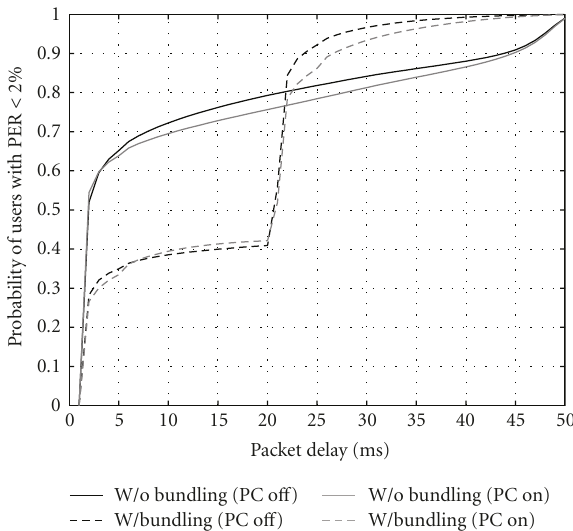
Figure 10: CDF of the number of PRBs scheduled per TTI (Macro Case 3).